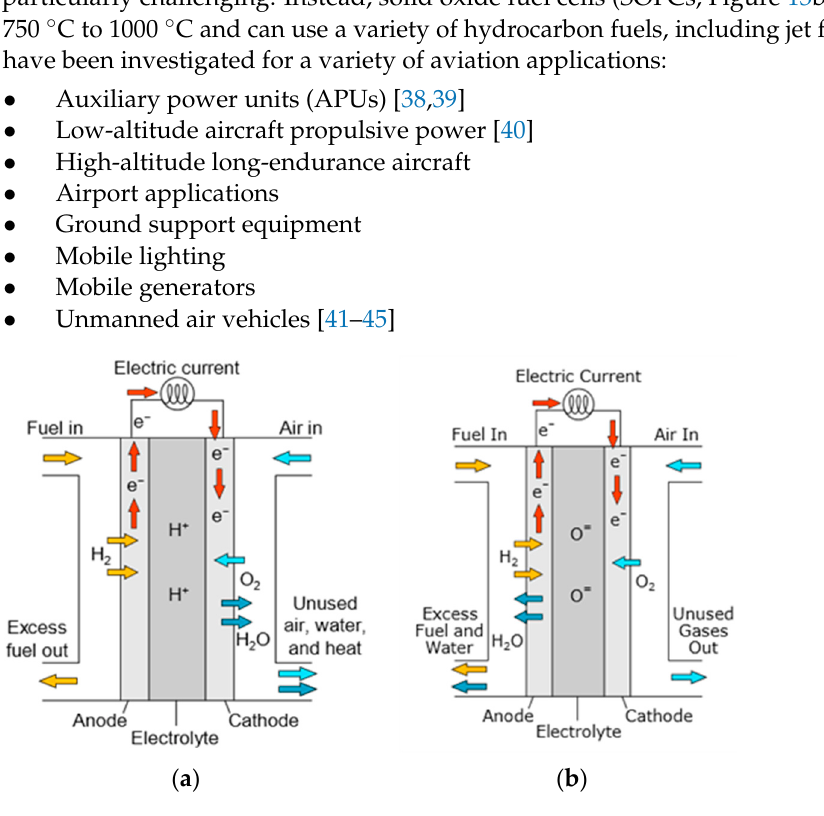
Figure 13. Scheme of two types of fuel cells: ( a ) PEM fuel cell; ( b ) SOFC fuel